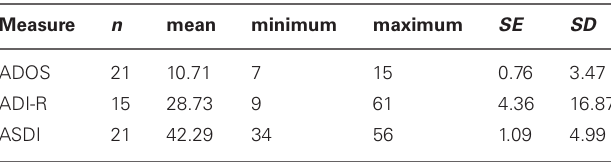
Table 1 | Diagnostic scores for the ASD group ( n , mean, minimum, maximum, SE , SD